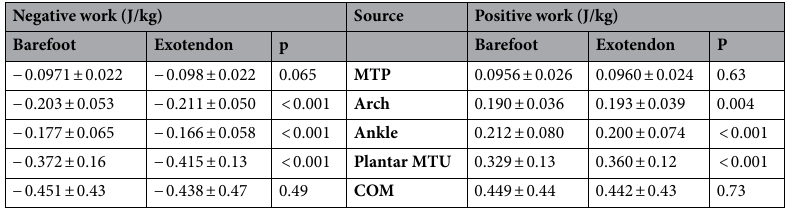
Table 2. Measures presented are averaged across all participants and are presented in the format mean ± standard deviation for the barefoot and exotendon conditions. The 3rd column has the p-value for the fixed efficient coefficient for the exotendon condition in the linear mixed effects model, where p < 0.05 was considered significant.